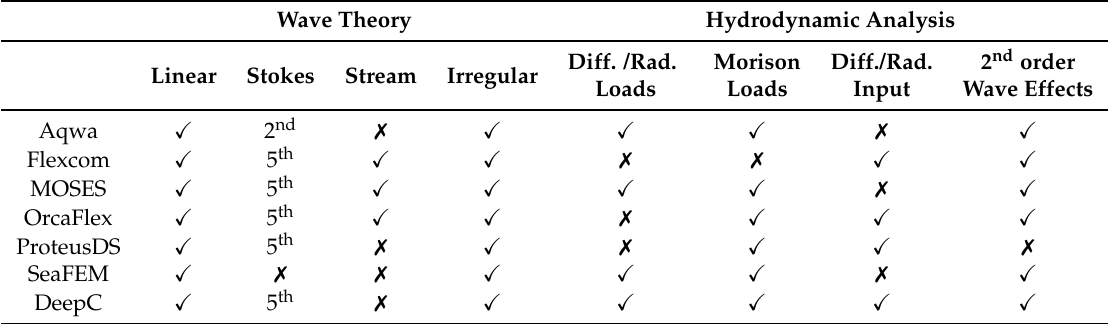
Table 3. Comparison of the software capabilities of modeling waves. (cid:88) and (cid:55) denote respectively that the capability is available or